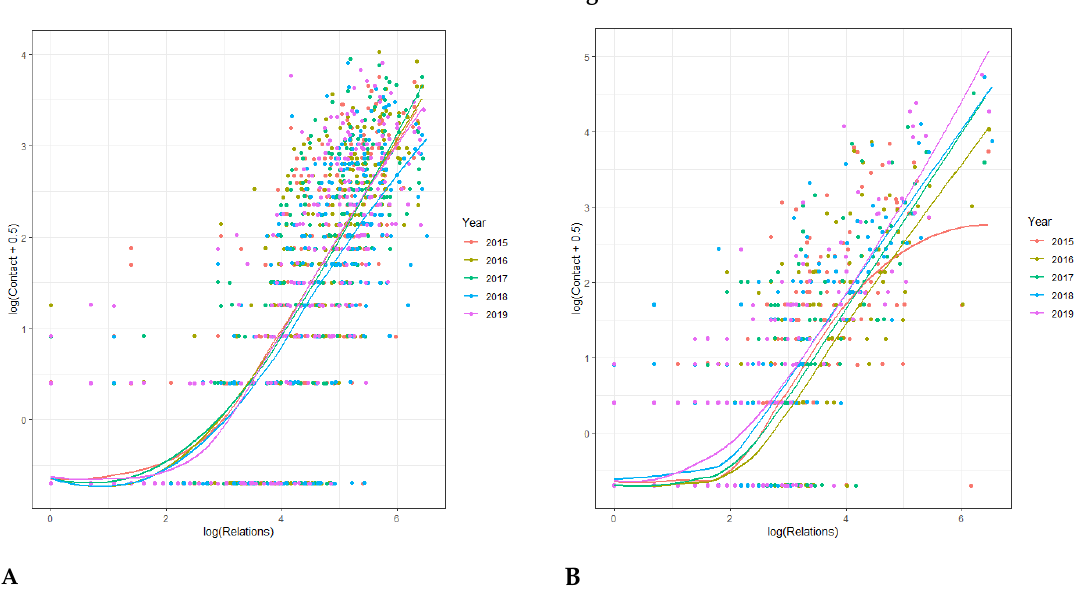
Figure 5. Scatterplot of the relation between contact with the veterinary helpdesk and number of registered relations of veterinary practices for cattle ( A ) and pigs ( B ).